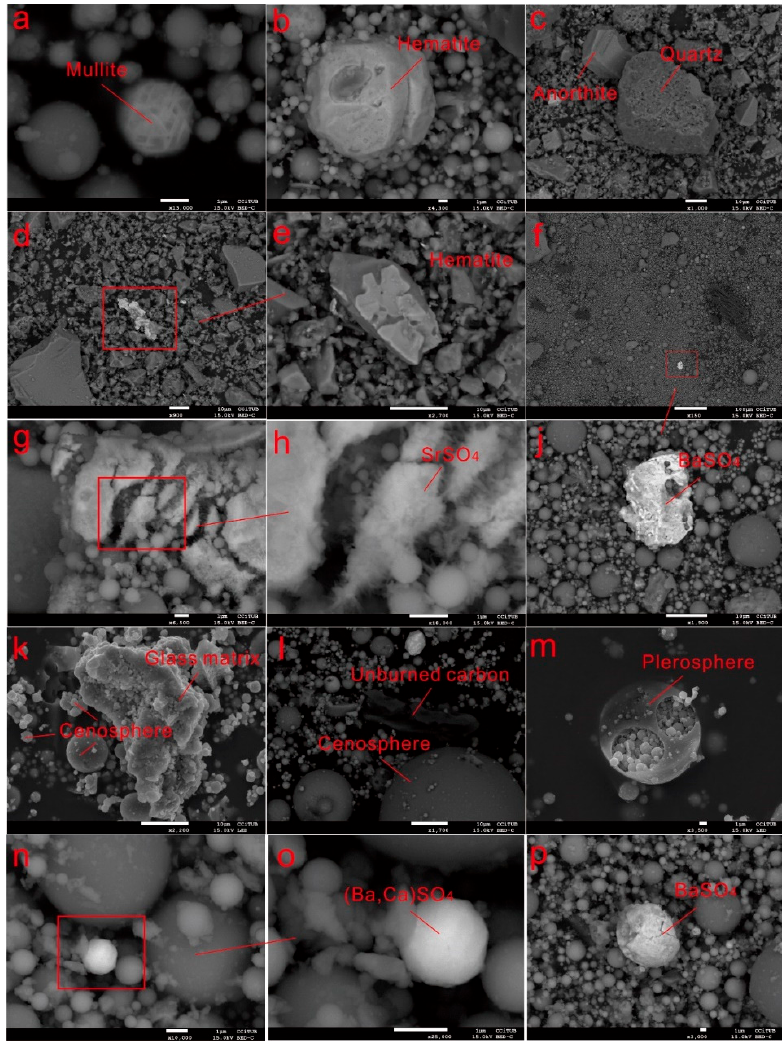
Figure 5. Scanning electron microscope (SEM) image of minerals in fly ash and slag. a : Mullite in S-FAf; b : Henatite in S-FAc; c : Anorthite and quartz in slag; d , e : Hematite in slag; f , j : BaSO 4 in S-FAc; g , h : SrSO 4 in S-FAf; k : Glass matrix and cenosphere in S-FAf; l : Unburned carbon and cenosphere in S-FAf; m : Plerosphere in S-FAf; n , o : (Ba, Ca)SO 4 in Y-FA; and p : BaSO 4 in Y-FA.